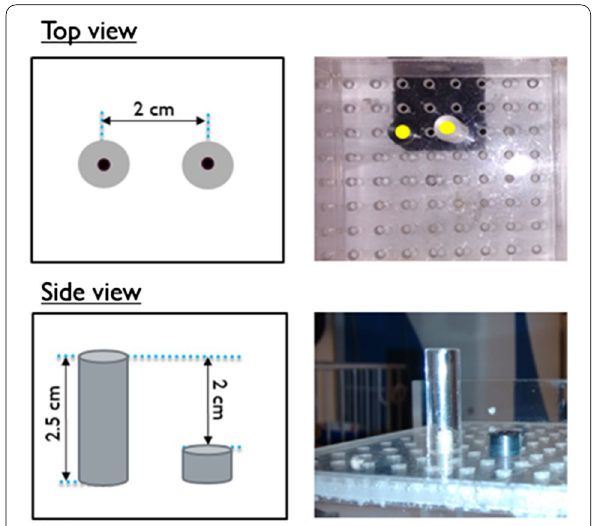
Fig. 3 Schematic diagram and photographs of phantom used to evaluate source localization accuracy. The point sources are at the top surfaces of the two acrylic posts